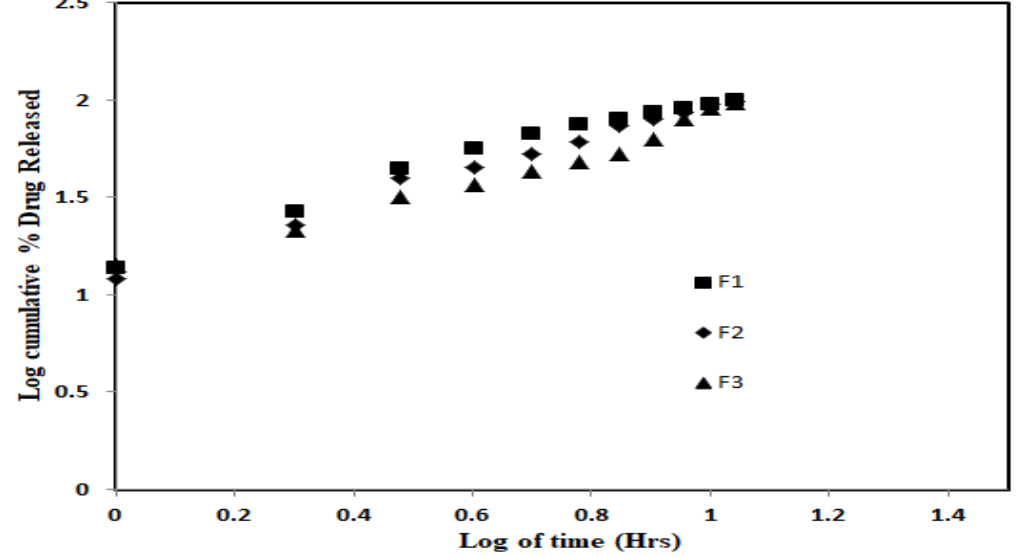
Figure 5. In vitro release kinetics of SGN from SGN-TC nanoparticles (F1–F3).